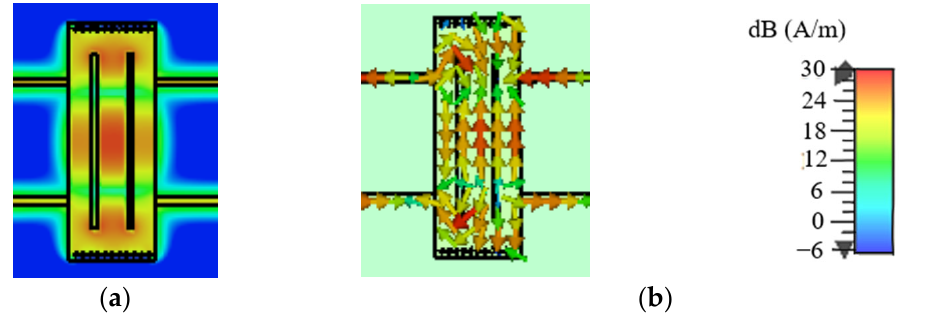
Figure 3. The surface current distributions on the SIW with two slots for DM operating at f 0 . ( a ) The uniform amplitude distributions. ( b ) The vector distributions.